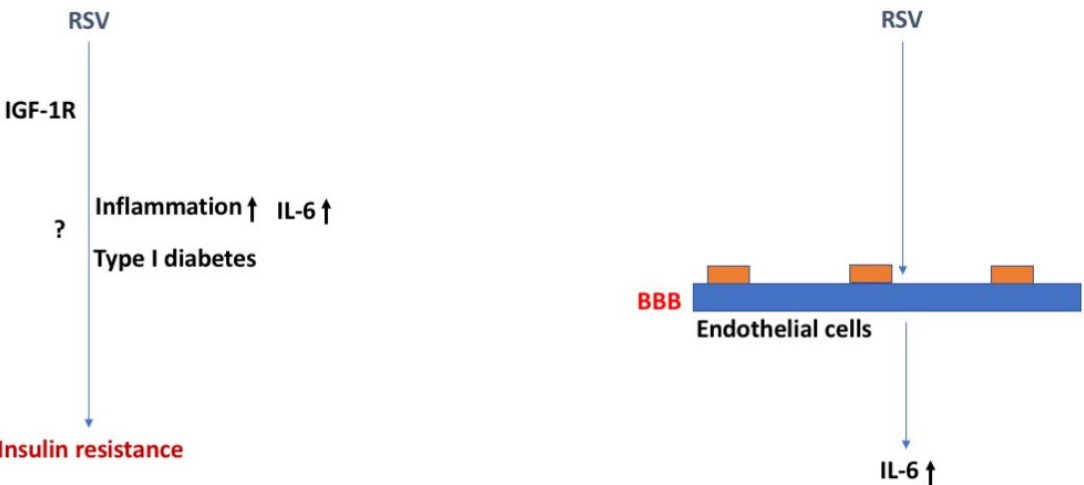
Figure 5. RSR, insulin resistance, and the BBB. RSV might induce insulin resistance via the IGF-1R and involve inflammation, especially enhanced IL-6 levels, and type I diabetes. The arrows in bold indicate the direction of the effects. For more details, see text.